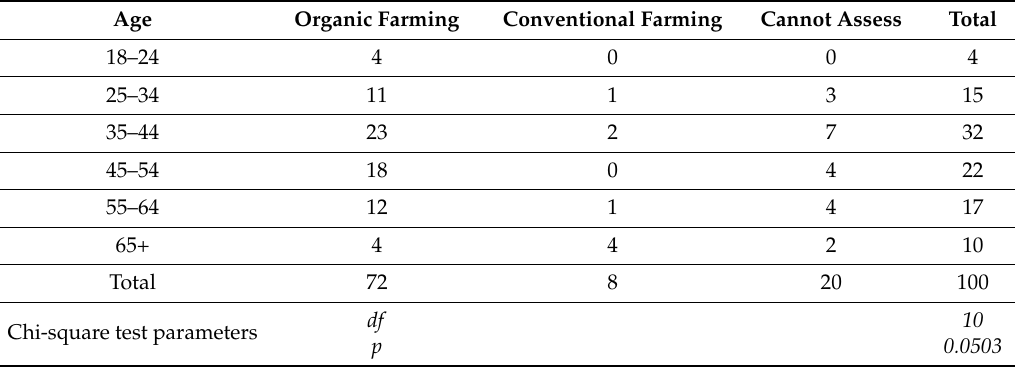
Table 5. Responses regarding sustainable food production by age